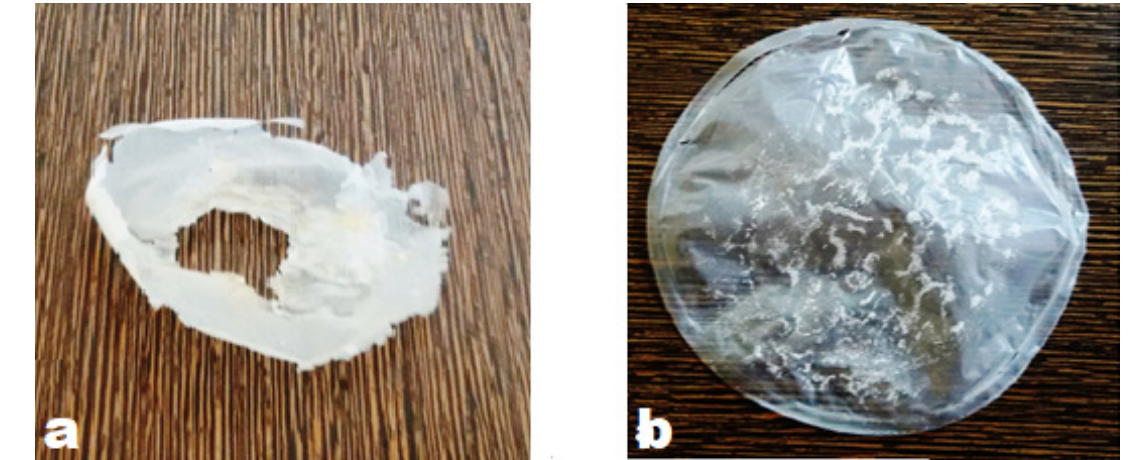
Figure 8. ( a ) Control preparation (uninoculated NDM +PHB film) did not show any change in the morphology of the film. ( b ) NDM inoculated Pseudomonas sp. RZS1 and A. faecalis RZS4 showing roughening of the surface morphology and formation of holes in PHB, i.e., indicative of the biodegradation of PHB film